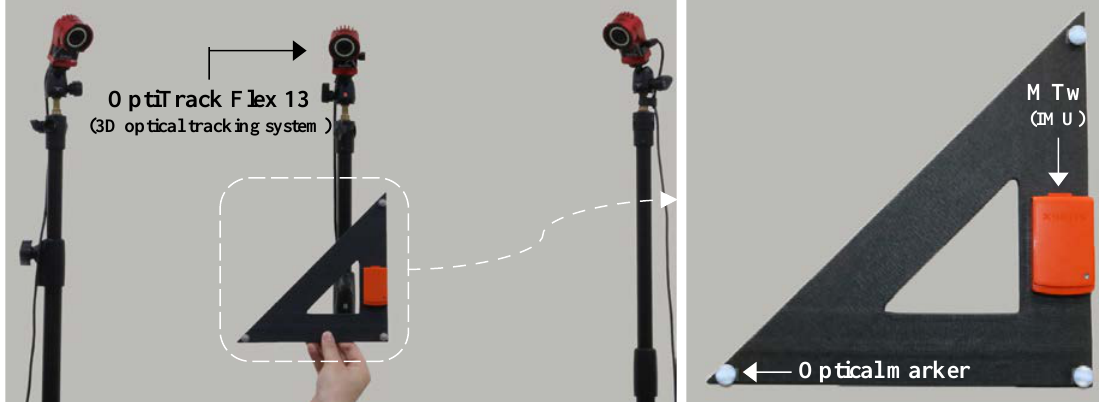
Figure 1. Experiment setup: three optical markers were attached to each vertex of the triangle ruler using double-side adhesive tapes.